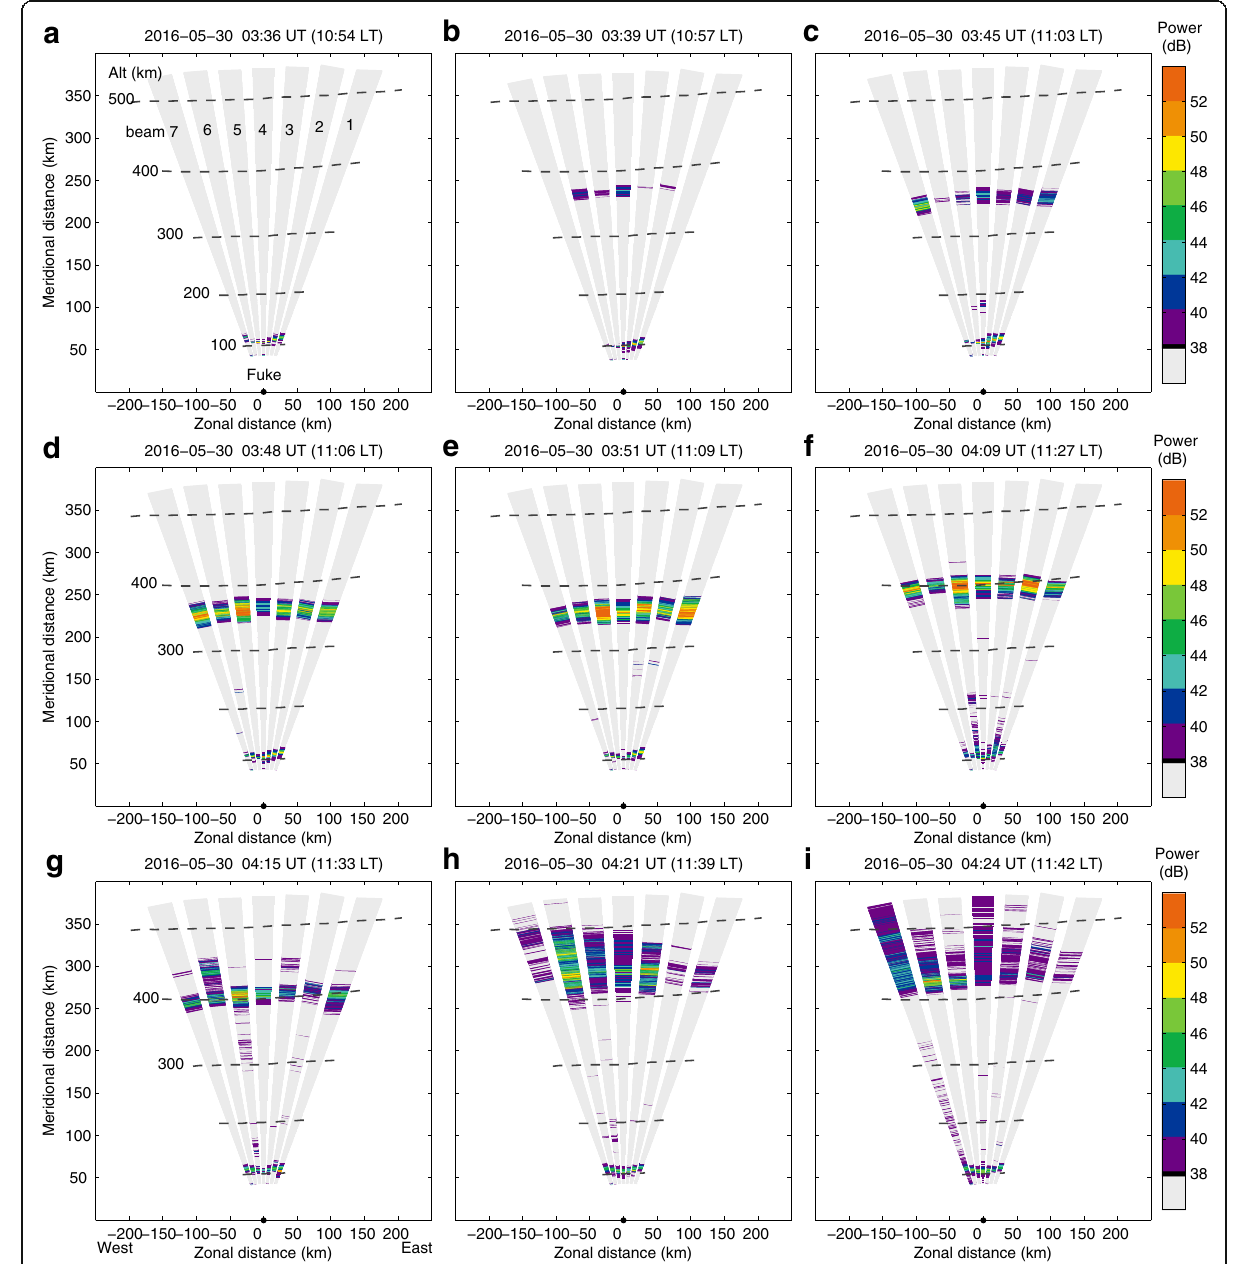
Fig. 2 a – i The fan sector maps of echo power (in dB) taken from 1054 LT (0336 UT) to 1142 LT (0424 UT) showing the onset and growth of F-region irregularities. The horizontal and vertical axes in each plot represent the zonal and meridional distance from the radar site on the Earth ’ s surface, respectively. The horizontal dashed lines in each plot show the altitudes (from 100 to 500 km with an altitude interval of 100 km) where the radar line of sight is perpendicular to the geomagnetic field. The zonal width of each beam indicates the half power beam